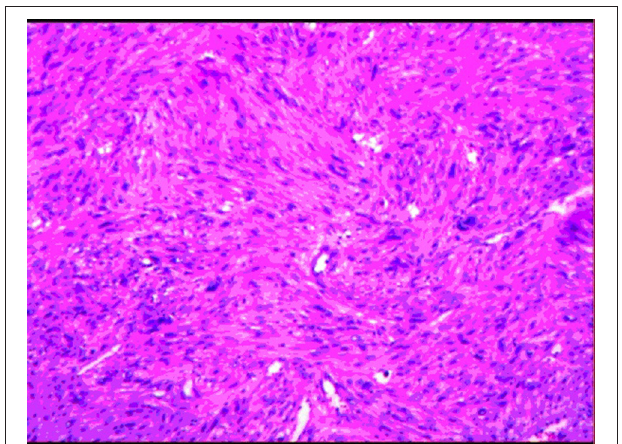
FIGURE 4 | Image showing spindle-shaped tumor cells with areas of hypercellularity that were arranged in fascicles, bundles and interlacing